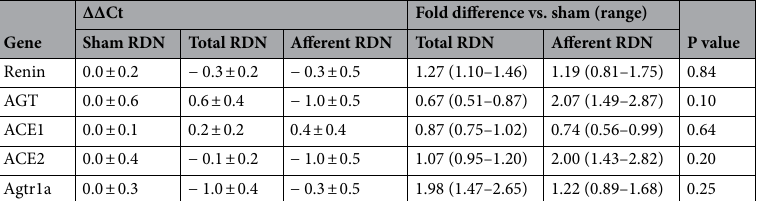
ΔΔCt Fold difference vs. sham (range) Gene